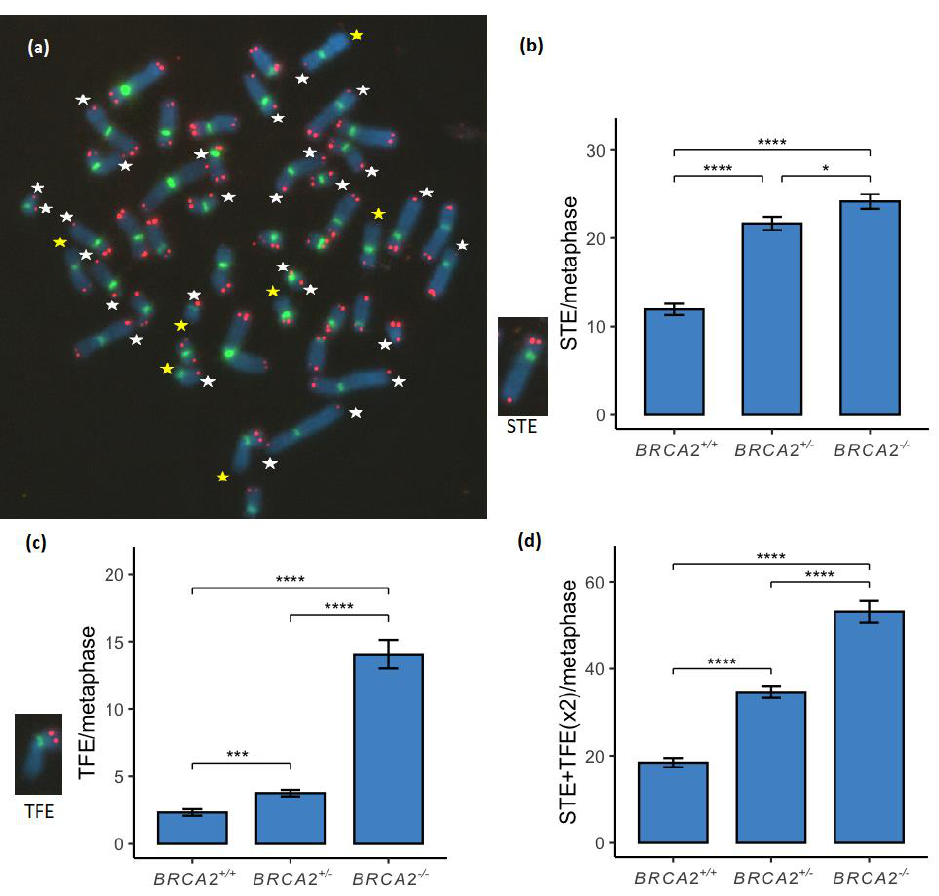
Figure 1. Telomere loss (TL) compared between the three BRCA2 genotypes of lymphoid cell lines. ( a ) In each metaphase single telomere end (STE) was measured as a loss of a telomere signal (red) from a single sister chromatid (white stars) and telomere free ends (TFE) on chromosomes were measured when both telomere signals from a chromosome end were lost (yellow stars). ( b ) STE was significantly increased between the wild-type and the BRCA2 +/- genotypes and between the wild- type and the BRCA2 -/- genotypes ( p < 0.0001), and significance was also found between the BRCA2 +/- and BRCA2 -/- genotypes ( p < 0.05). ( c ) TFE was significantly increased between the three genotypes of BRCA2 +/+ , BRCA2 +/- and BRCA2 -/- in a stepwise manner ( p < 0.001 and p < 0.0001, respectively). ( d ) TL was measured by a combination of numbers of STE and TFE duplicated. TL was significantly increased between the three genotypes of BRCA2 +/+ , BRCA2 +/- and BRCA2 -/- in a stepwise manner ( p < 0.0001). * corresponds to p < 0.05, *** corresponds to p < 0.001 and **** corresponds to p < 0.0001. Metaphase chromosomes were analyzed with FISH by Cy3-conjugated telomere probe and FITC- conjugated centromere probe and counterstained with DAPI. The metaphase shown is from the EB1690 BRCA2 +/- lymphoid cell